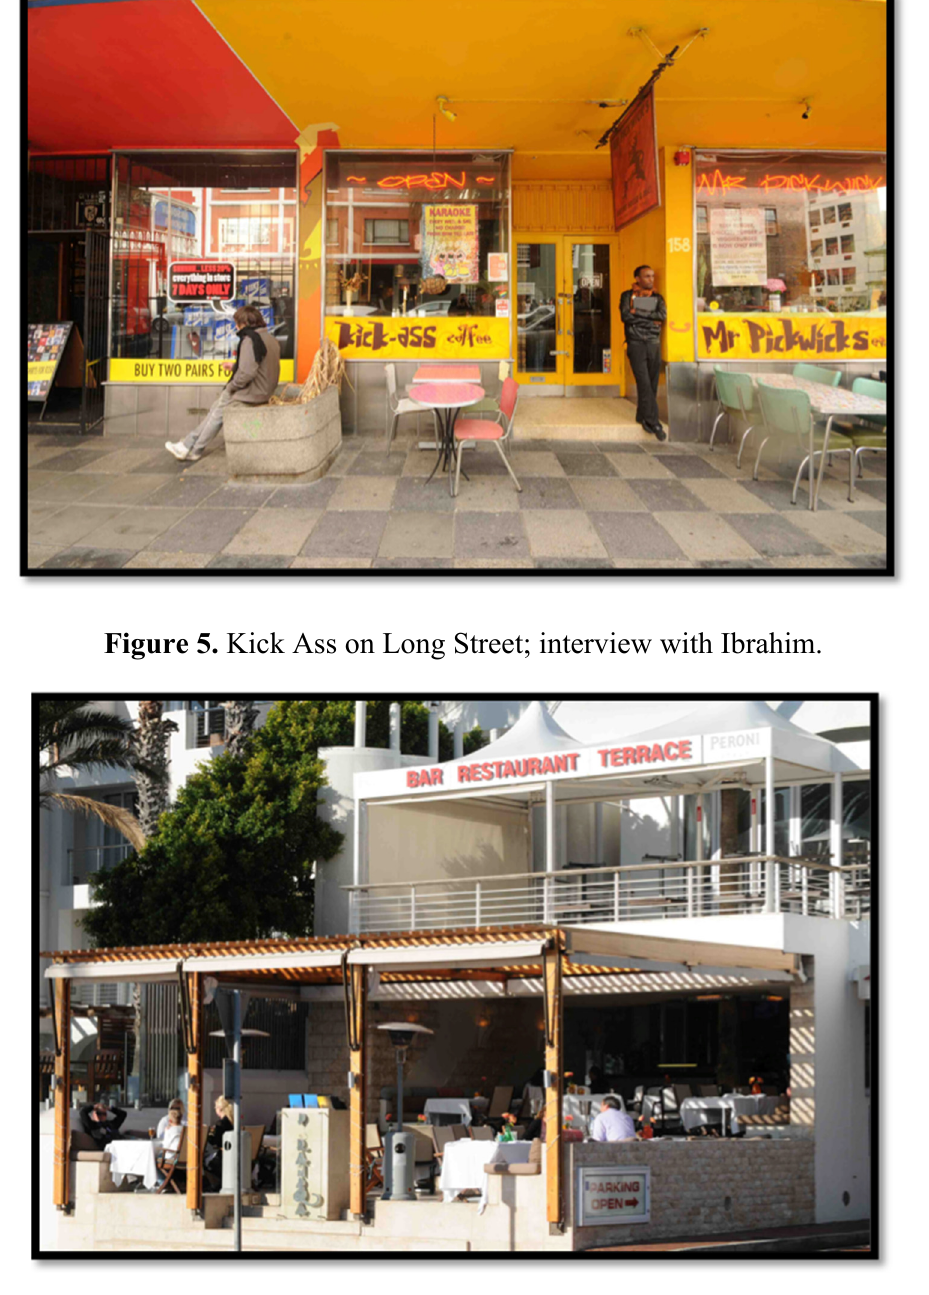
Figure 6. Camps Bay interview with